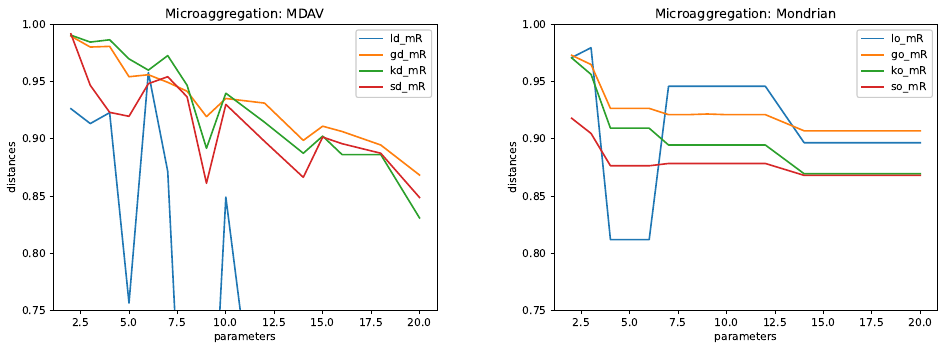
Figure 3. Rank correlation of mean Shapley values (_Rm) for MDAV ( left ) and Mondrian ( right ) (letters d and o) using linear regression (letter l), SGD Regressor (letter g), Kernel Ridge (letter k), and SVM (letter s). That is, ld_mR reads for linear regression as the machine learning method for data protected using MDAV and the curve corresponding to mean rank correlation. Computations for the Diabetes